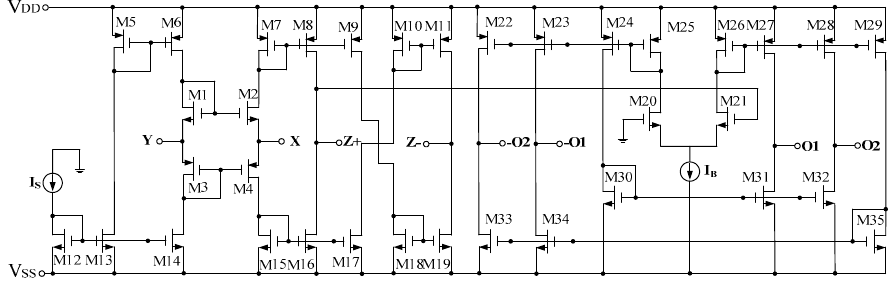
Figure 4. Complementary metal oxide semiconductor (CMOS) realization of the CCCCTA [29]. Table 6. The aspect ratios of the CMOS transistors in CCCCTA implementation.